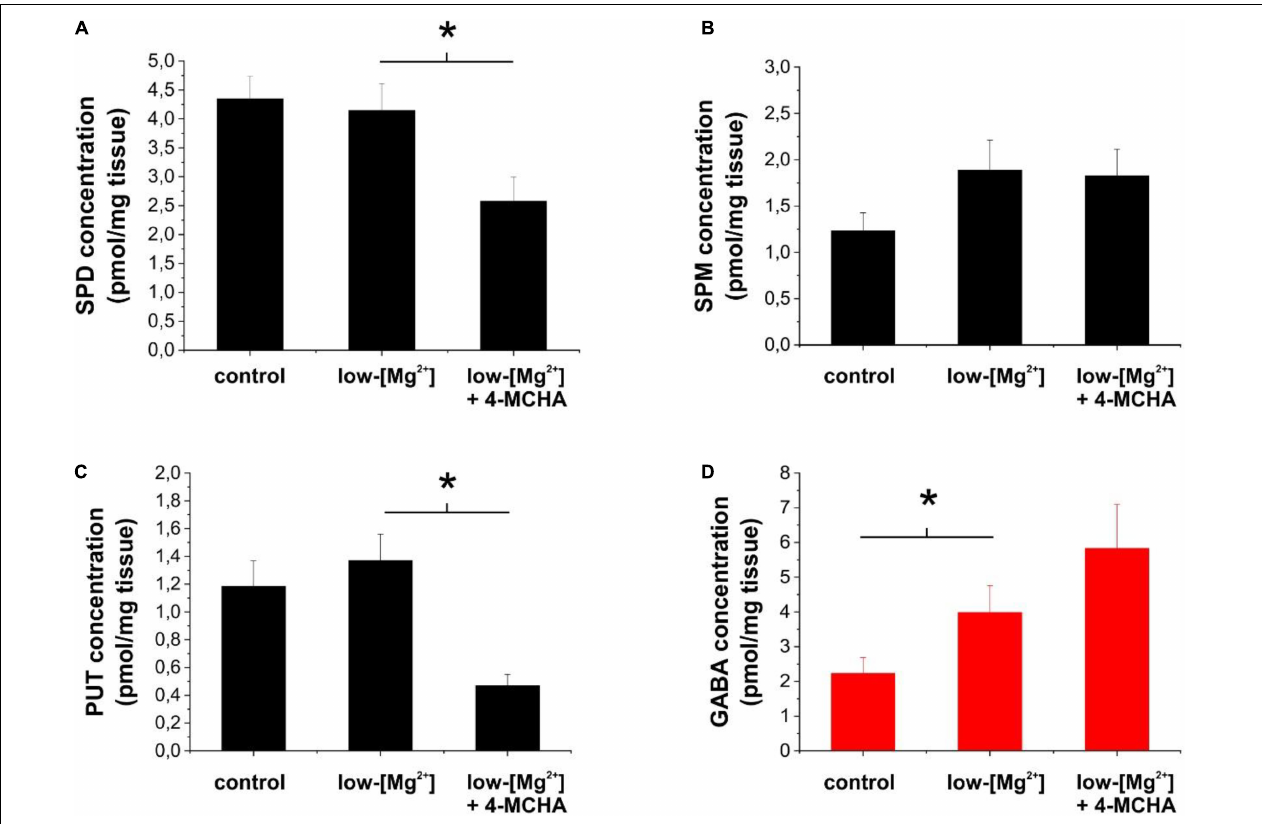
FIGURE 4 | Inhibition of spermidine synthesis decreases extracellular polyamine concentrations, but increases extracellular GABA concentration in brain slices. (A–D) Concentrations of spermidine (A) , spermine (B) , putrescine (C) , and GABA (D) in the bathing medium of hippocampal slices following 1 h incubation in normal ACSF (control) or in low-[Mg 2 + ] ACSF in the absence and presence of 250 µ M 4-MCHA as determined by LC-MS ( n = 8 animals). Asterisks denote significant difference ( p <